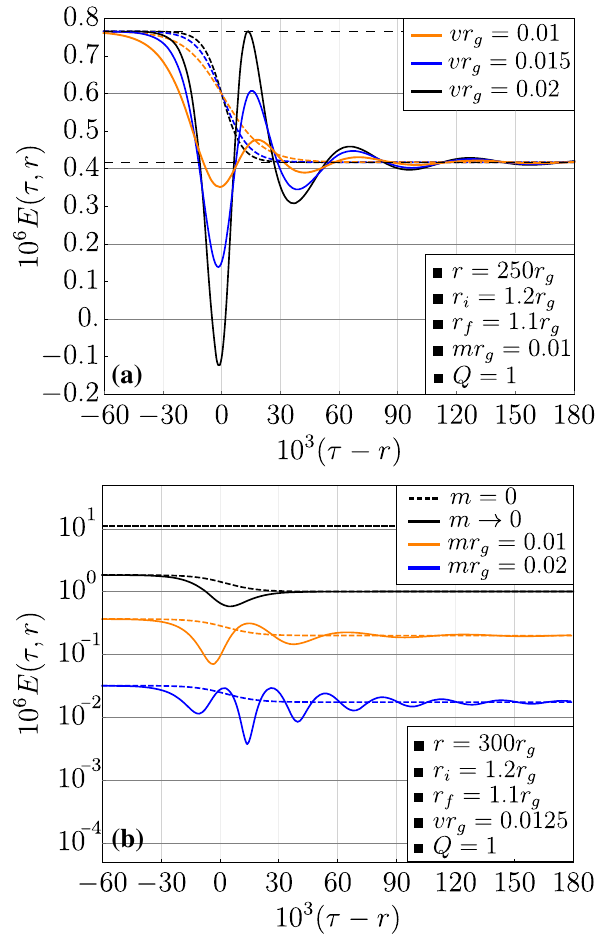
Fig. 3 The evolution of the Proca field strength of the shell contracted according to the law (55) depending on the rapidity ( a ) and the Proca mass ( b ). The additional parameters are also shown in the figure. Thin dashed curves correspond to the first term in the formula